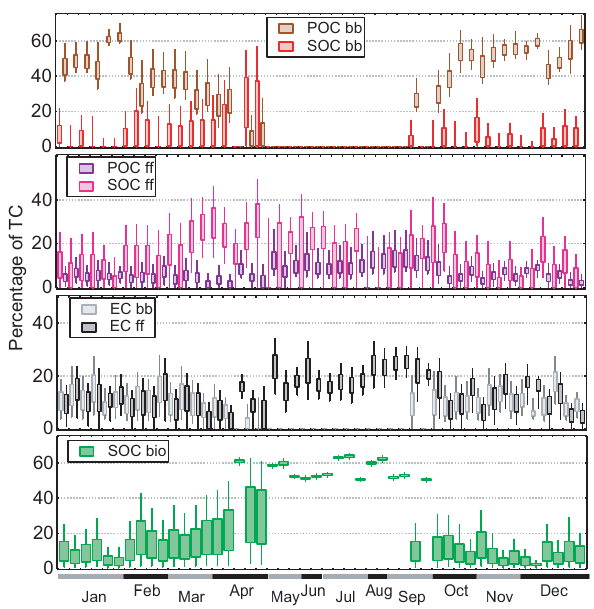
Fig. 5. Box-whisker plots of Quasi Monte Carlo simulation output for each day and each carbon source: POC bb and SOC bb (panel a ), POC ff and SOC ff (panel b ), EC bb and EC ff (panel c ), and SOC bio (panel d